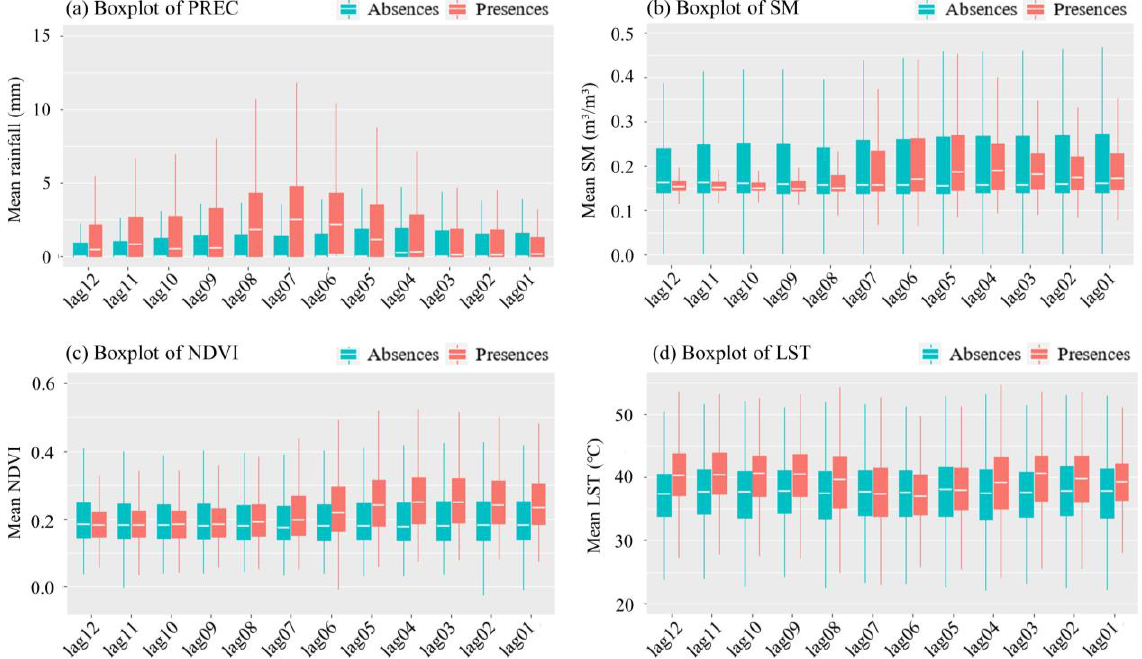
Figure 5. Value distributions of dynamic indicators at different time-lagged variables. ( a ) Boxplot of PREC. ( b ) Boxplot of SM. ( c ) Boxplot of NDVI. ( d ) Boxplot of LST. The red box represents the value distributions of dynamic indicators in band presences while the green box refers to that in band absences.